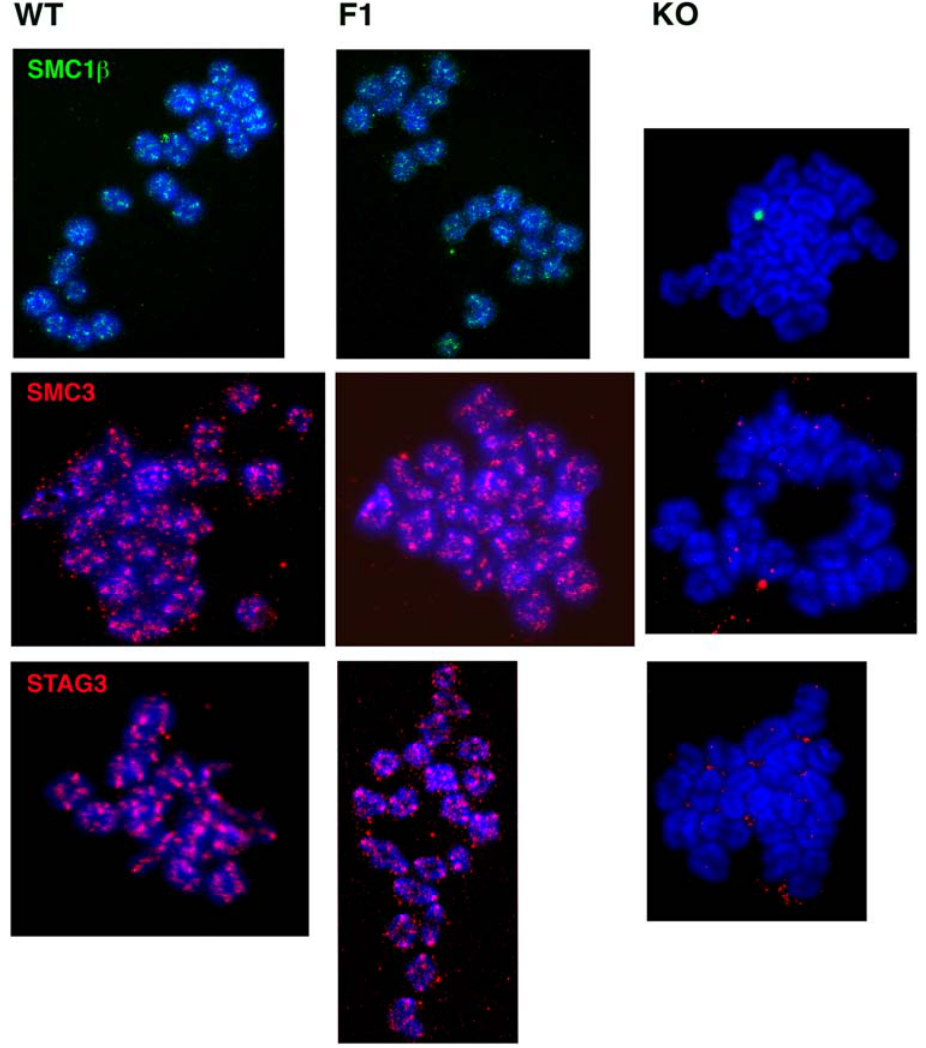
Figure 2. Immunofluorescence staining of cohesins SMC1 β (green), SMC3 (red), and STAG3 (red) on metaphase I chromosomes of oocytes from wild-type (WT), Smc1 β fl/fl GDF9-Cre (F1), and Smc1 β -/- (KO) mice of two-to-three months of age. Chromosomes are stained by DAPI